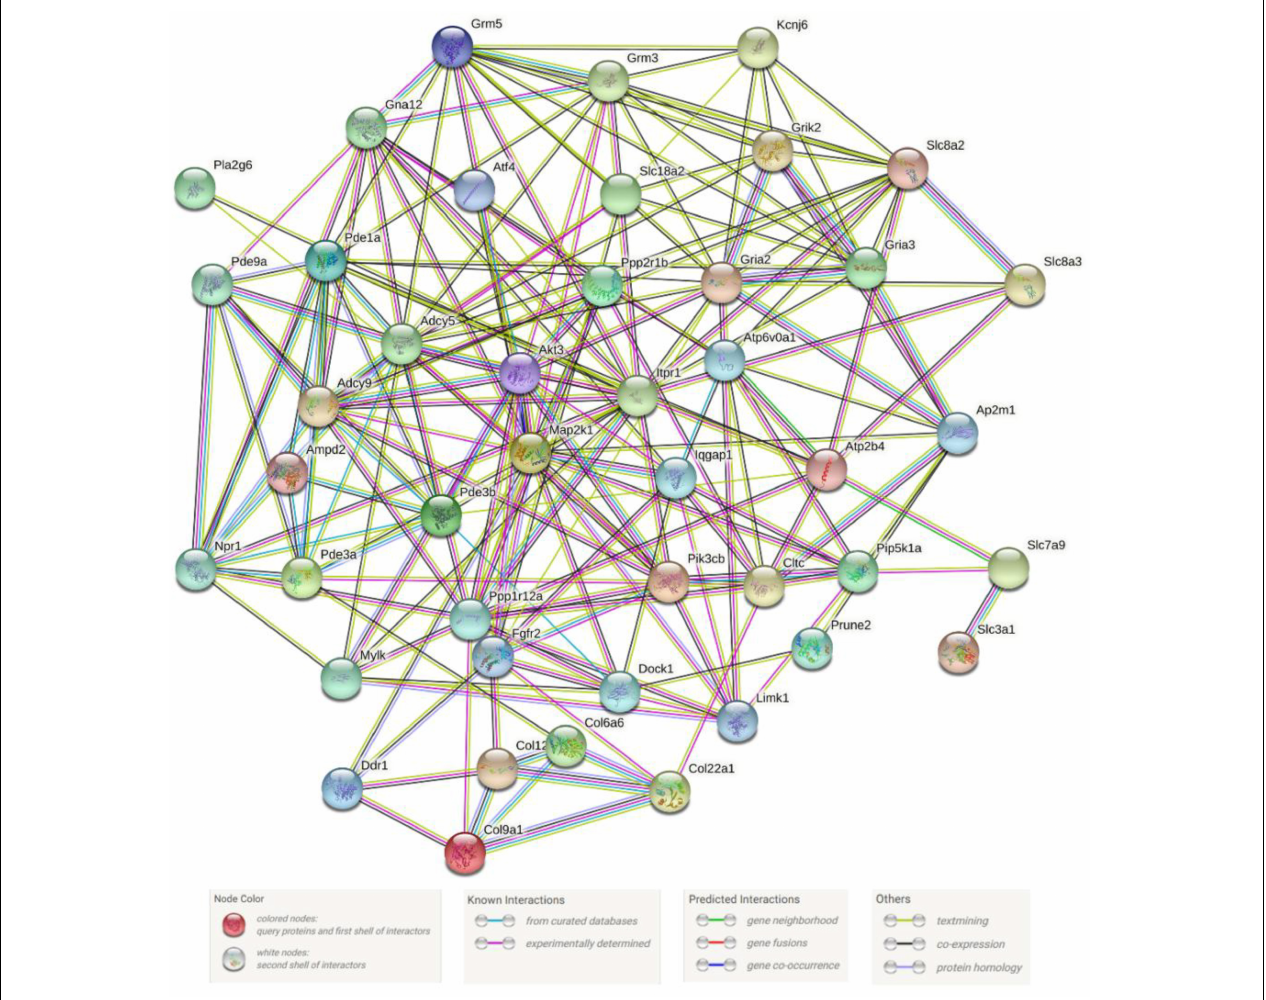
FIGURE 6 | Metabolism-related protein–protein interaction networks. Network nodes stand for proteins. The legend represents the relationships between nodes.